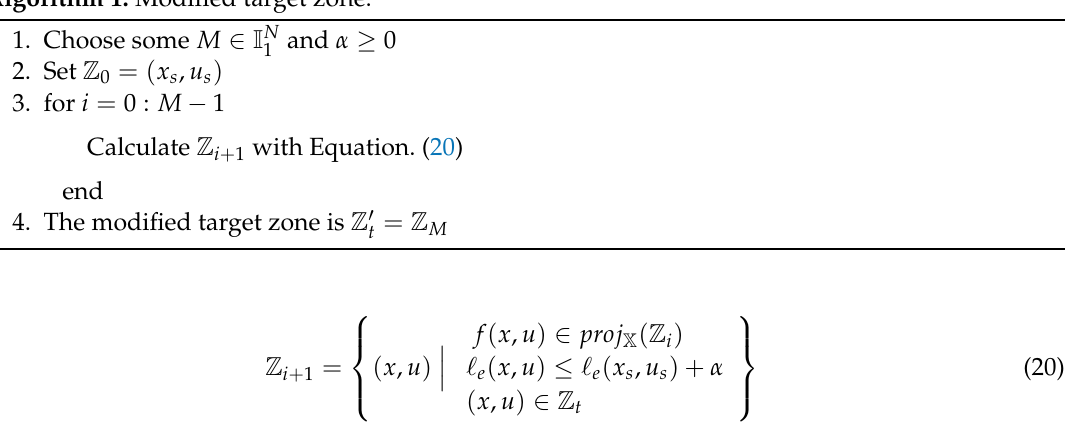
Algorithm 1: Modified target